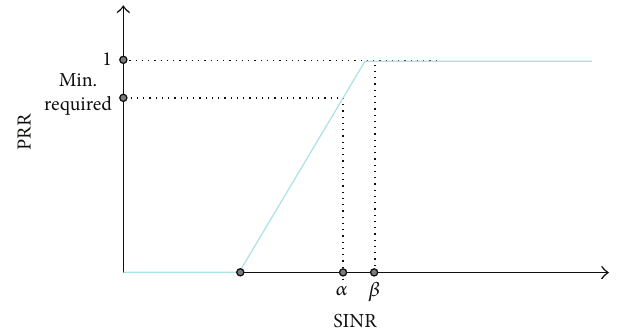
Figure 1: SINR graded model. 𝛼 and 𝛽 are the lower and upper bounds of the desired SINR value, respectively, as described in (2) and